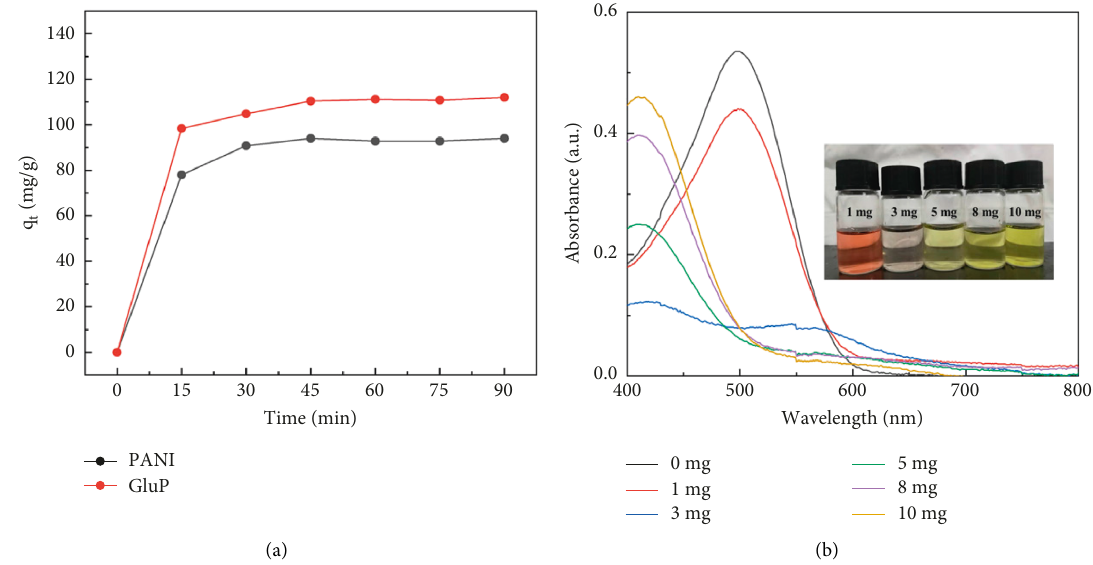
Figure 4: (a) Adsorption capacity of PANI and GluP at room temperature for CR (0.25 g · L − 1 absorbent, 30mg · L − 1 dye, pH � 7). (b) Ultraviolet-visible spectra of CR with different adsorbent doses at a fixed dye concentration for 3 h (30mg · L − 1 dye, 25 ° C, pH �